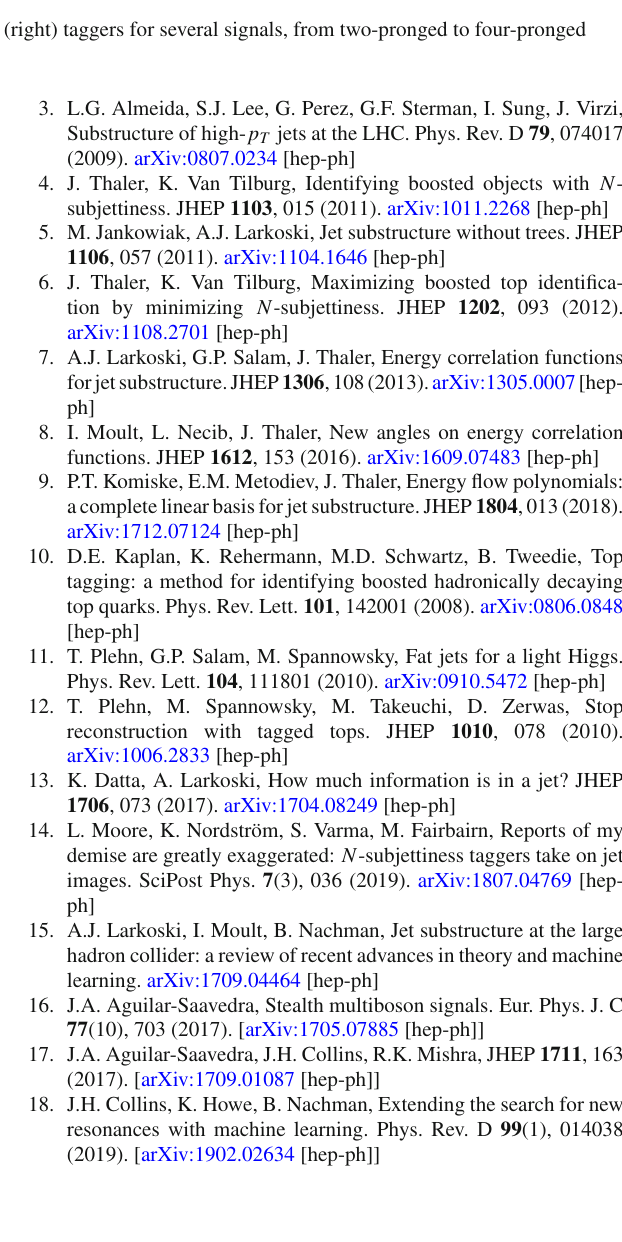
Fig. 11 Comparison of the performance of 4P hi80 (left) and hi200 (right) taggers for several signals, from two-pronged to four-pronged